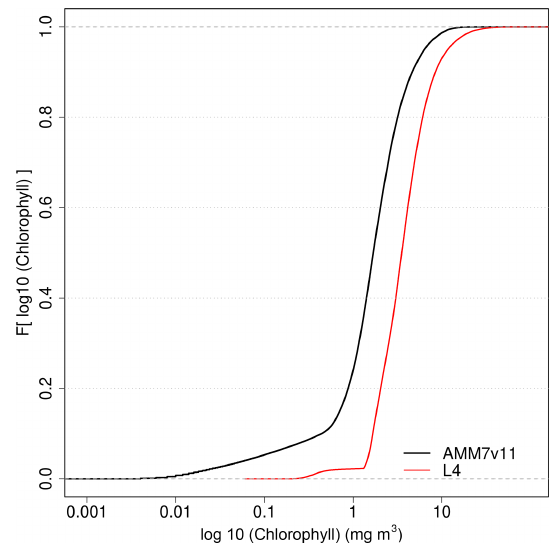
Figure 4. Empirical cumulative distribution functions of the log 10 Chl- a concentration for the L4 ocean colour product and AMM7v11 analyses for the 2019 bloom